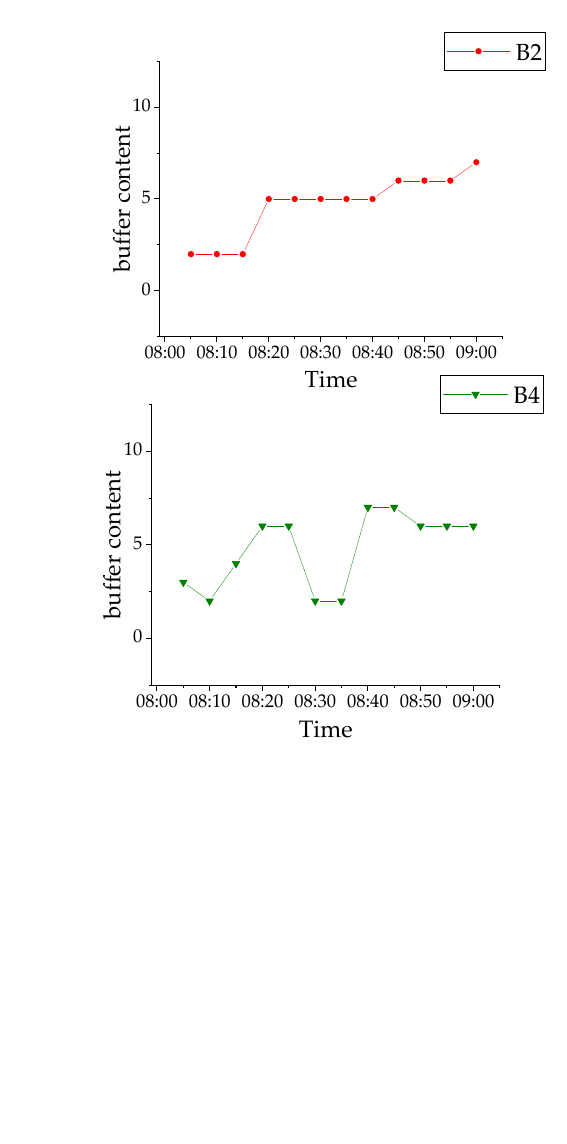
Figure 4. The six-machine-five-buffer (6M5B) tandem line.